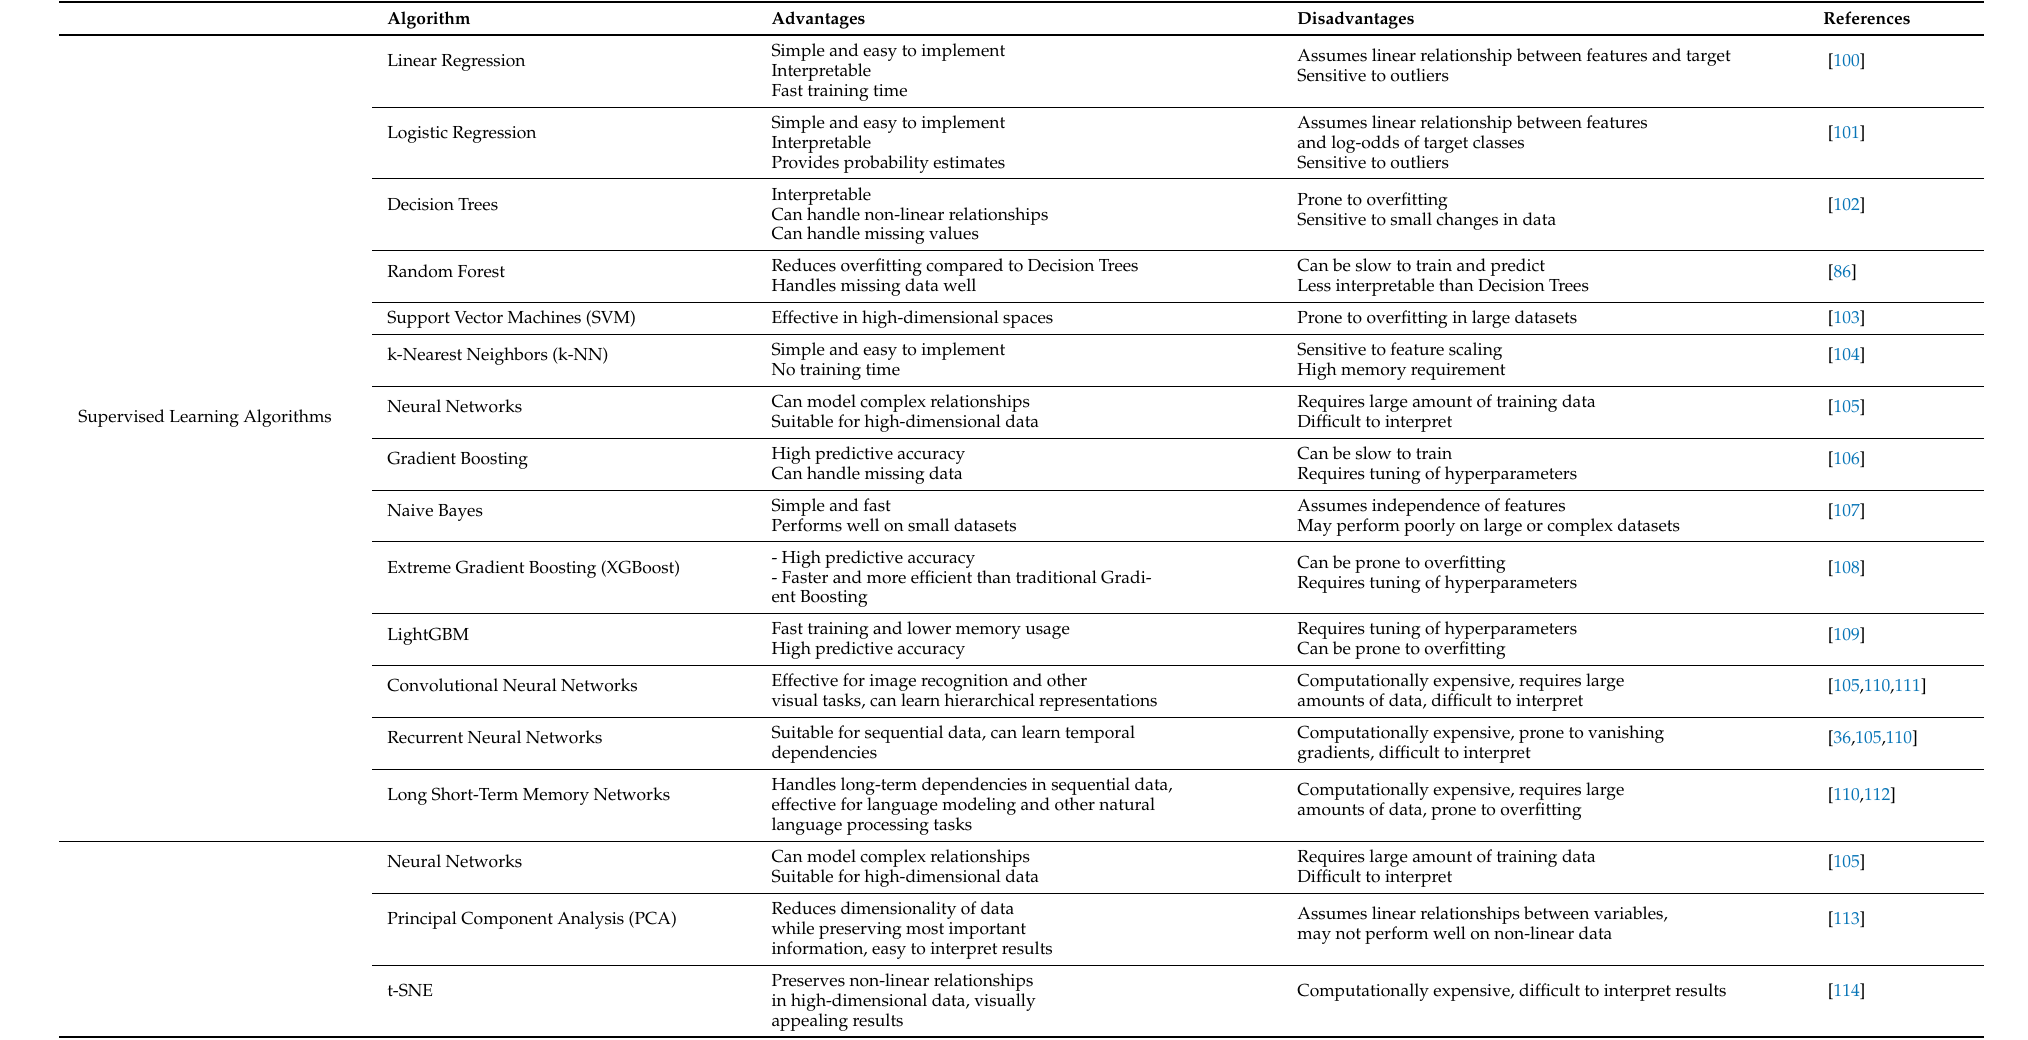
Table 3. Machine Learning Algorithm